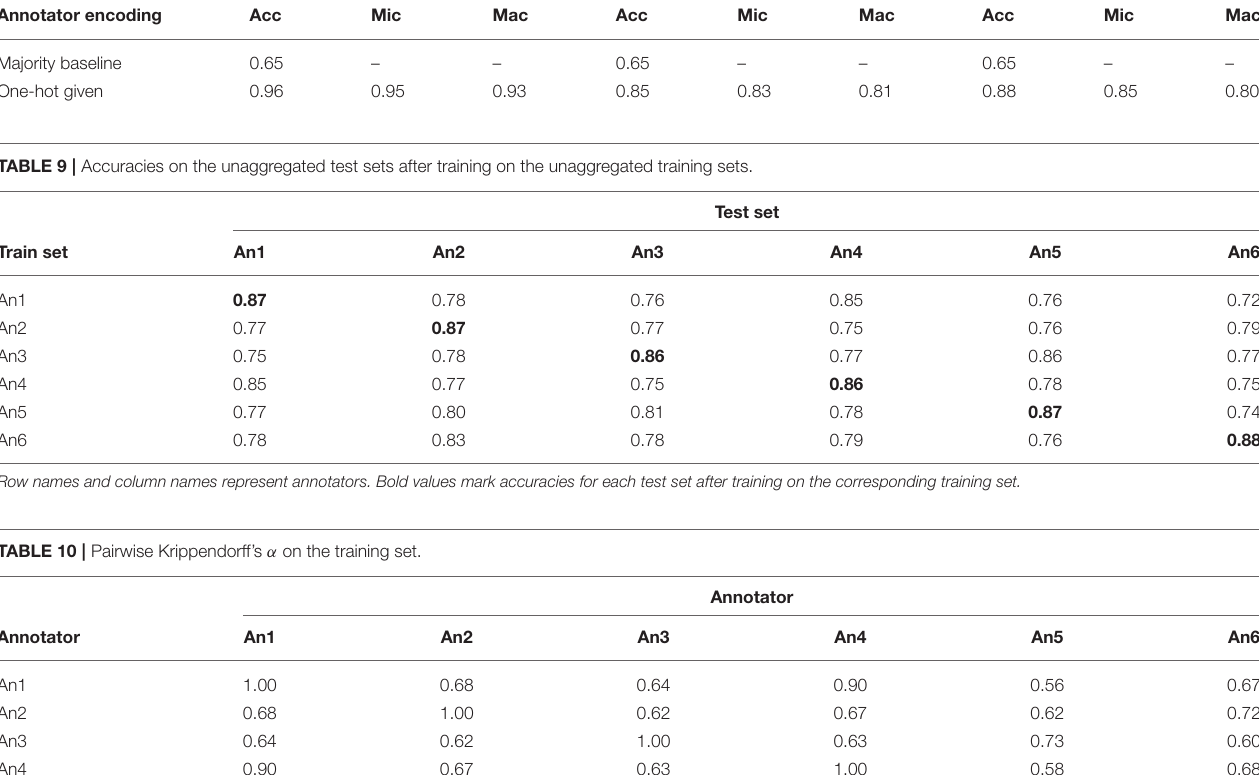
TABLE 8 | Performances on the aggregated training, development and test sets after training on the aggregated training set with one-hot annotator encodings. Train set